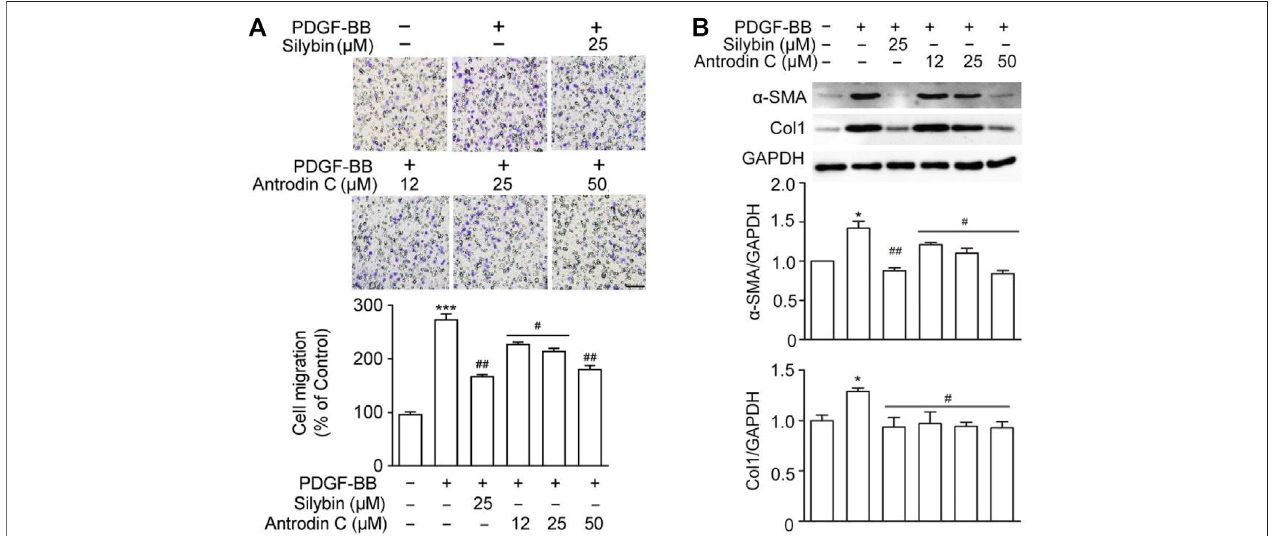
FIGURE 4 | Effects of Antrodin C on PDGF-BB induced cell migration, α -SMA and Col1 production in CFSC-8B cells. (A) Representative images of migrated CSFC-8B cells treated with or without Antrodin C (12 – 50 μ M) and Silybin in the presence or absence of PDGF-BB. The data were normalized to % of migrated control cells. Scale bar, 100 μ m. (B) Western blot analysis of α -SMA and Col1 expression. GAPDH was used as an internal control. Data represent mean ± SD ( n = 3), *** p < 0.001 compared with control; # p < 0.05, ## p < 0.01, ### p < 0.001 compared with PDGF-BB treated